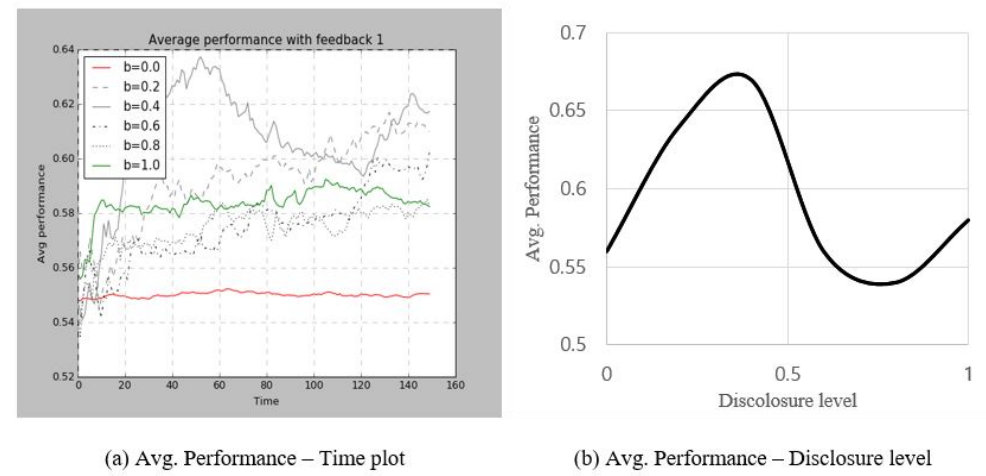
Figure A2. Average performance result of ‘positive feedback to high-performed group’ condition model.